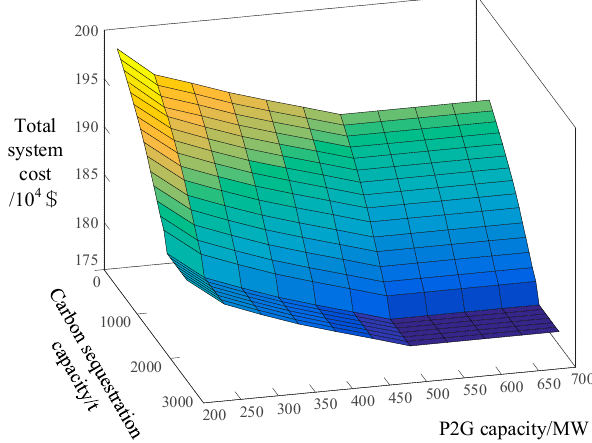
Figure 10. Total cost of different carbon storage capacity and P2G capacity.